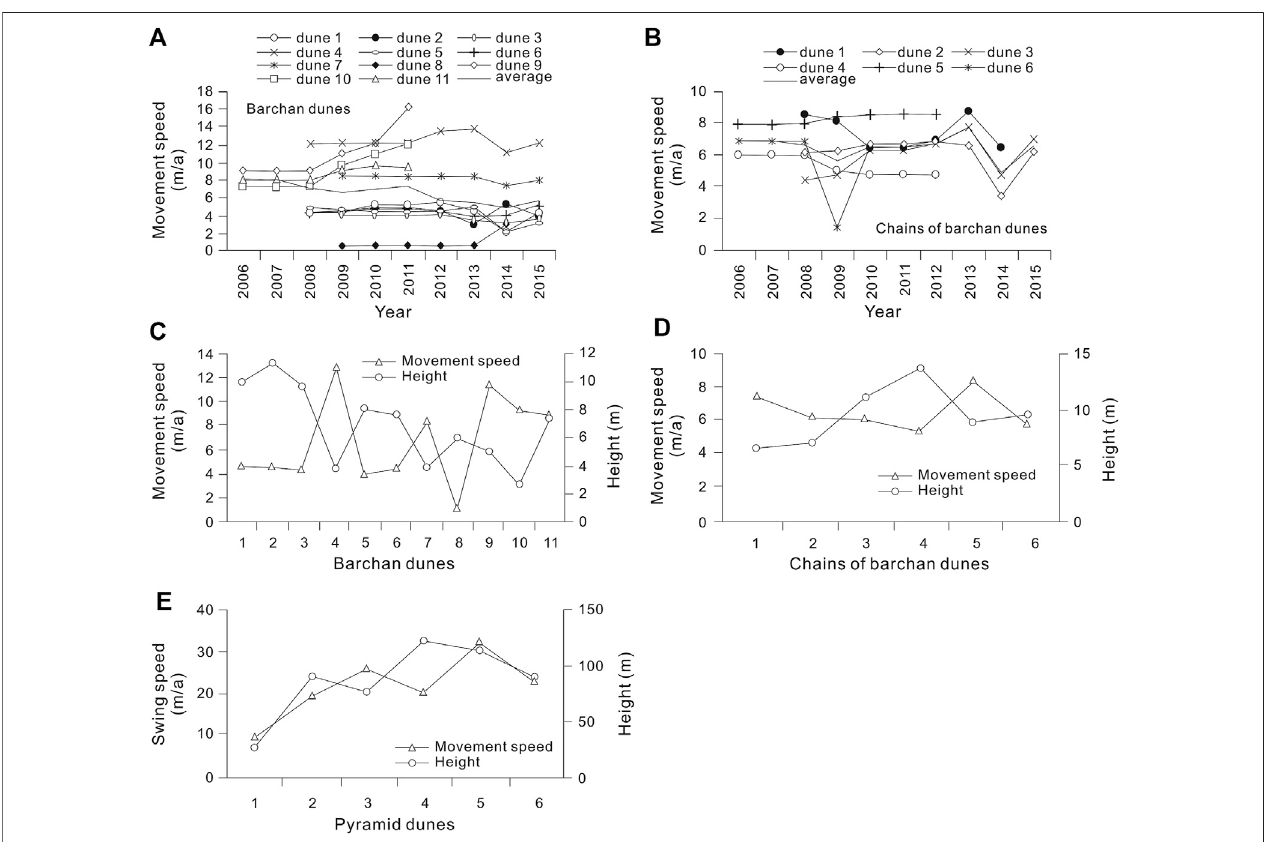
FIGURE 3 | The moving speed and height of sand dunes in the Hexi Corridor (modi fi ed after Chang et al. (2016)). (A) the moving speed of crescent-shaped (barchan) dunes; (B) the moving speed of chains of barchan dunes; (C) the moving speed and height of barchans dunes; (D) the moving speed and height of chains of barchan dunes; (E) the movement speed and height of pyramidal